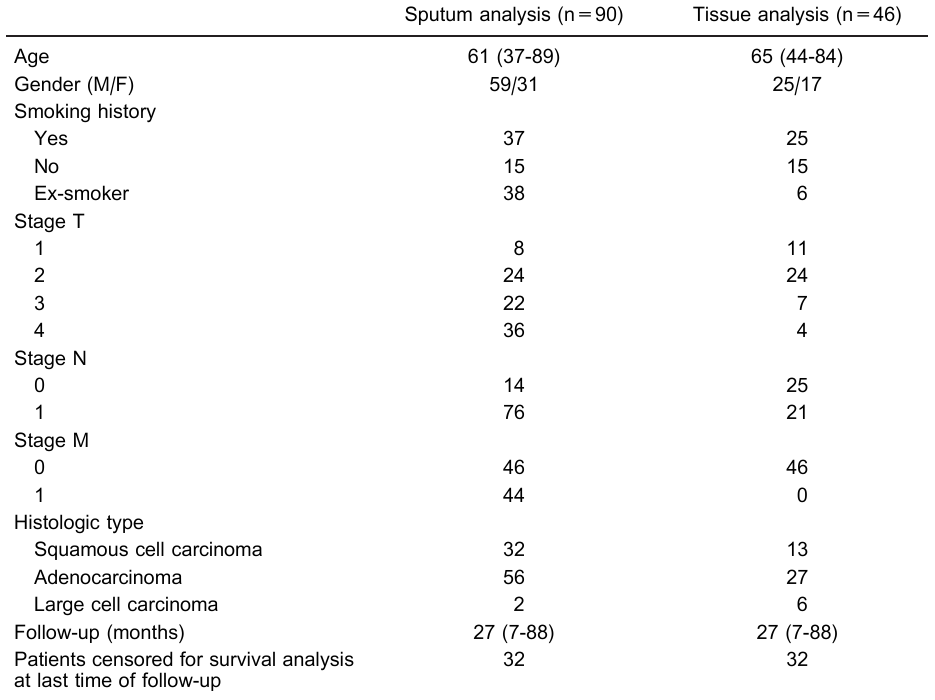
Table 1. Clinical features of lung cancer